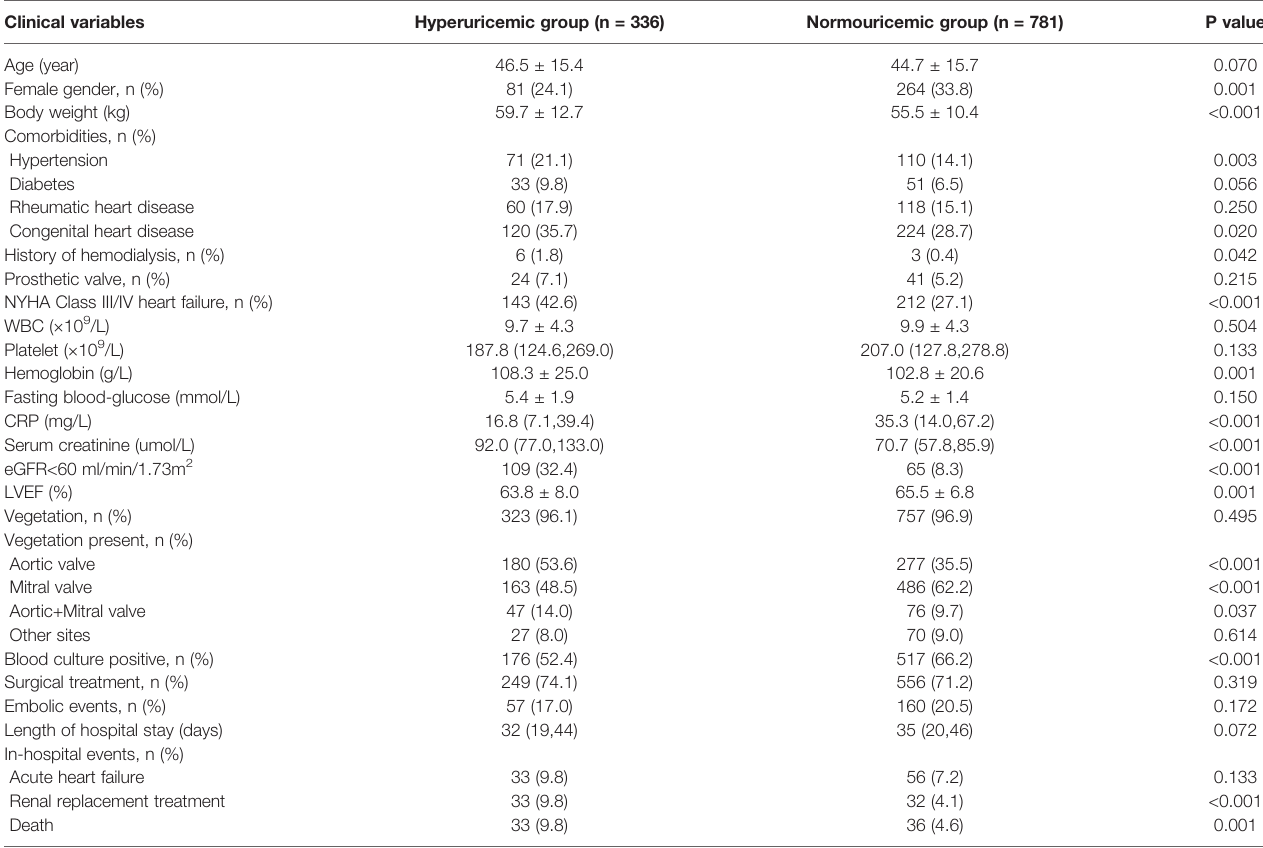
TABLE 1 | Baseline characteristics. Clinical